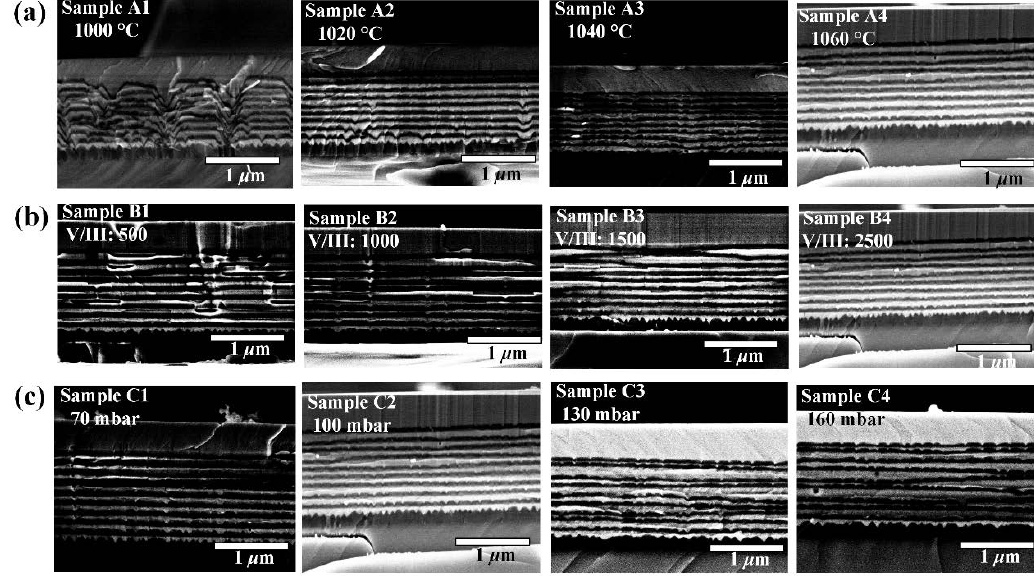
Figure 3. Cross-sectional SEM images of ( a ) series A, ( b ) series B and ( c ) series C.